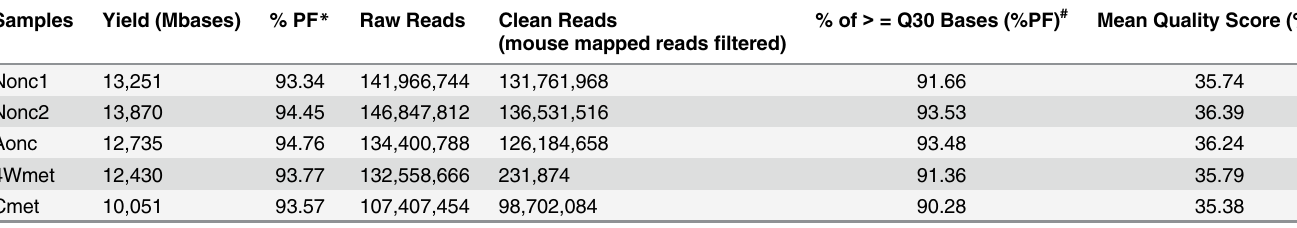
Table 2. Overview of the sequencing reads.